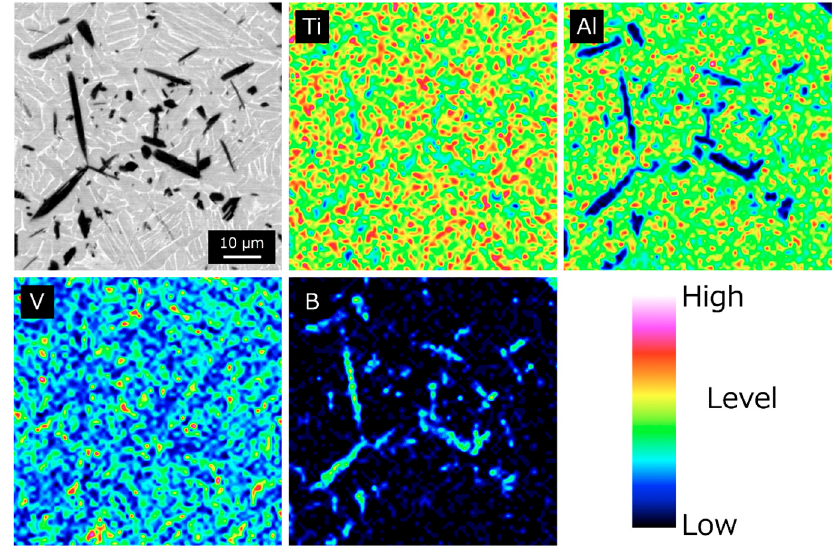
Figure 4. FE-EPMA results of SPS compact consolidated (~12.5 vol.% TiB in the final composite) at 1100 °C for 30 min.